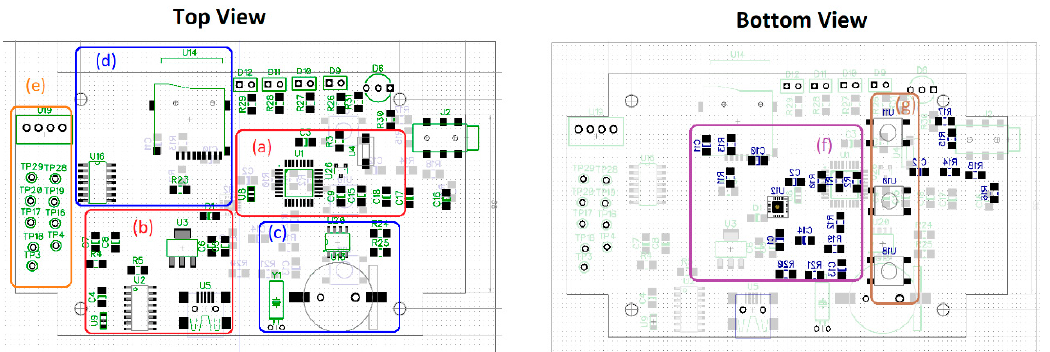
Figure 6. Top and bottom view of the printed circuit, highlighting distinct areas. ( a ) and ( b ) components of the Arduino Nano board; ( c ) and ( d ) data logger shield; ( e ) HC-05 Bluetooth module terminals and Vout, Vin, GND pins; ( f ) ECG circuit with AD8232 microchip; and ( g ) push-button